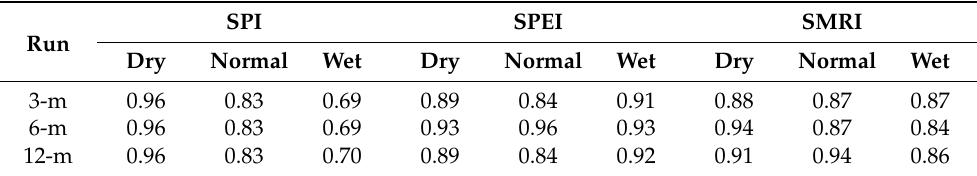
Table 6. Brier Skill Score (BSS) of ERA5 data representing drought over ULB using SPI, SPEI, SMRI.